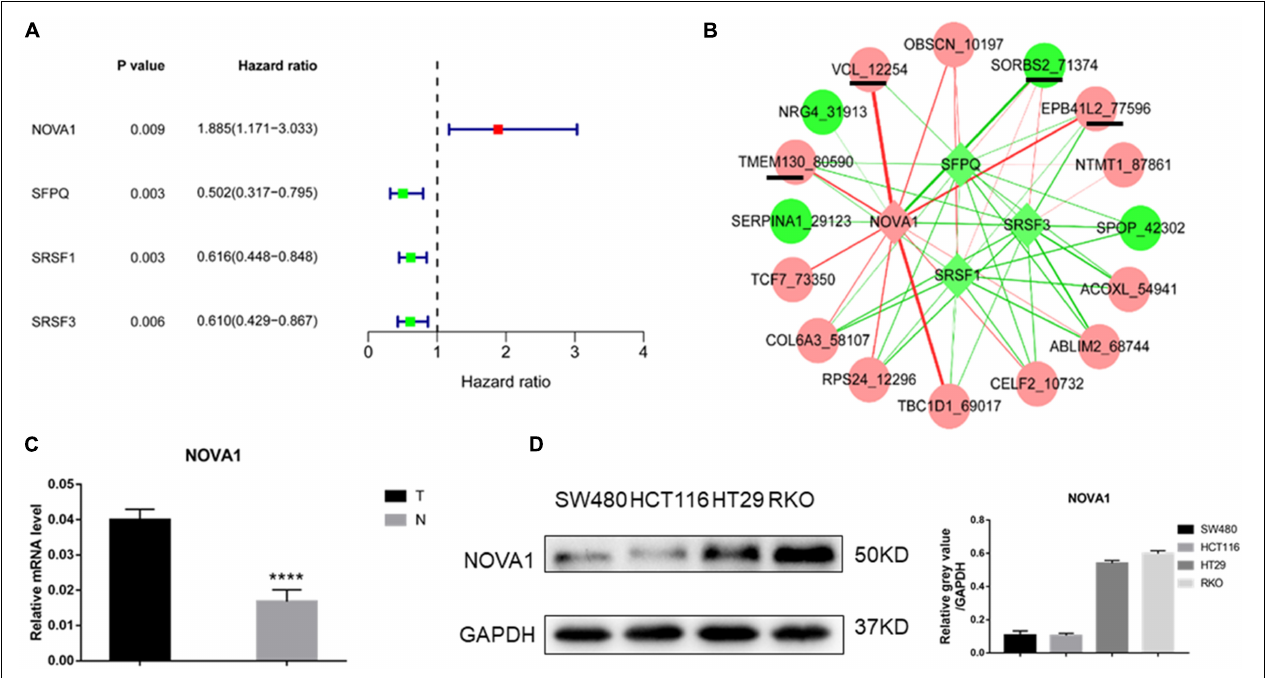
FIGURE 3 | Identification of splicing factor regulating the hub gene AS events. (A) Of the 66 splice factor genes, three splicing factors were associated with good prognosis, and one splicing factor was related to poor prognosis by univariate Cox regression analysis. (B) Coexpression network of splicing factor gene expression, and gene AS events showed that four of the above five hub gene AS events were significantly related to NOVA1 mRNA expression. (C) qPCR was used to detect the expression of NOVA1 in five paired normal and tumor tissues. (D) The expression of NOVA1 in four CRC cell lines. Each experiment was representative of three independent experiments. * p < 0.05, ** p < 0.01, **** p <